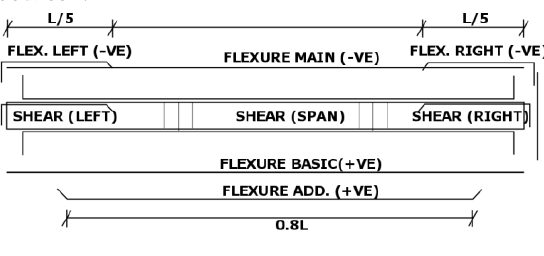
Figure 1. Reinforcement configuration for